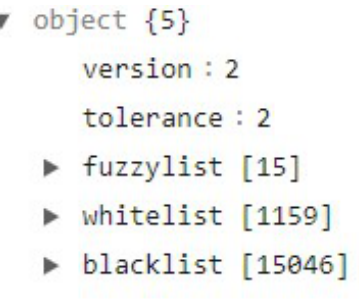
Figure 32. Metamask app recovered lists.